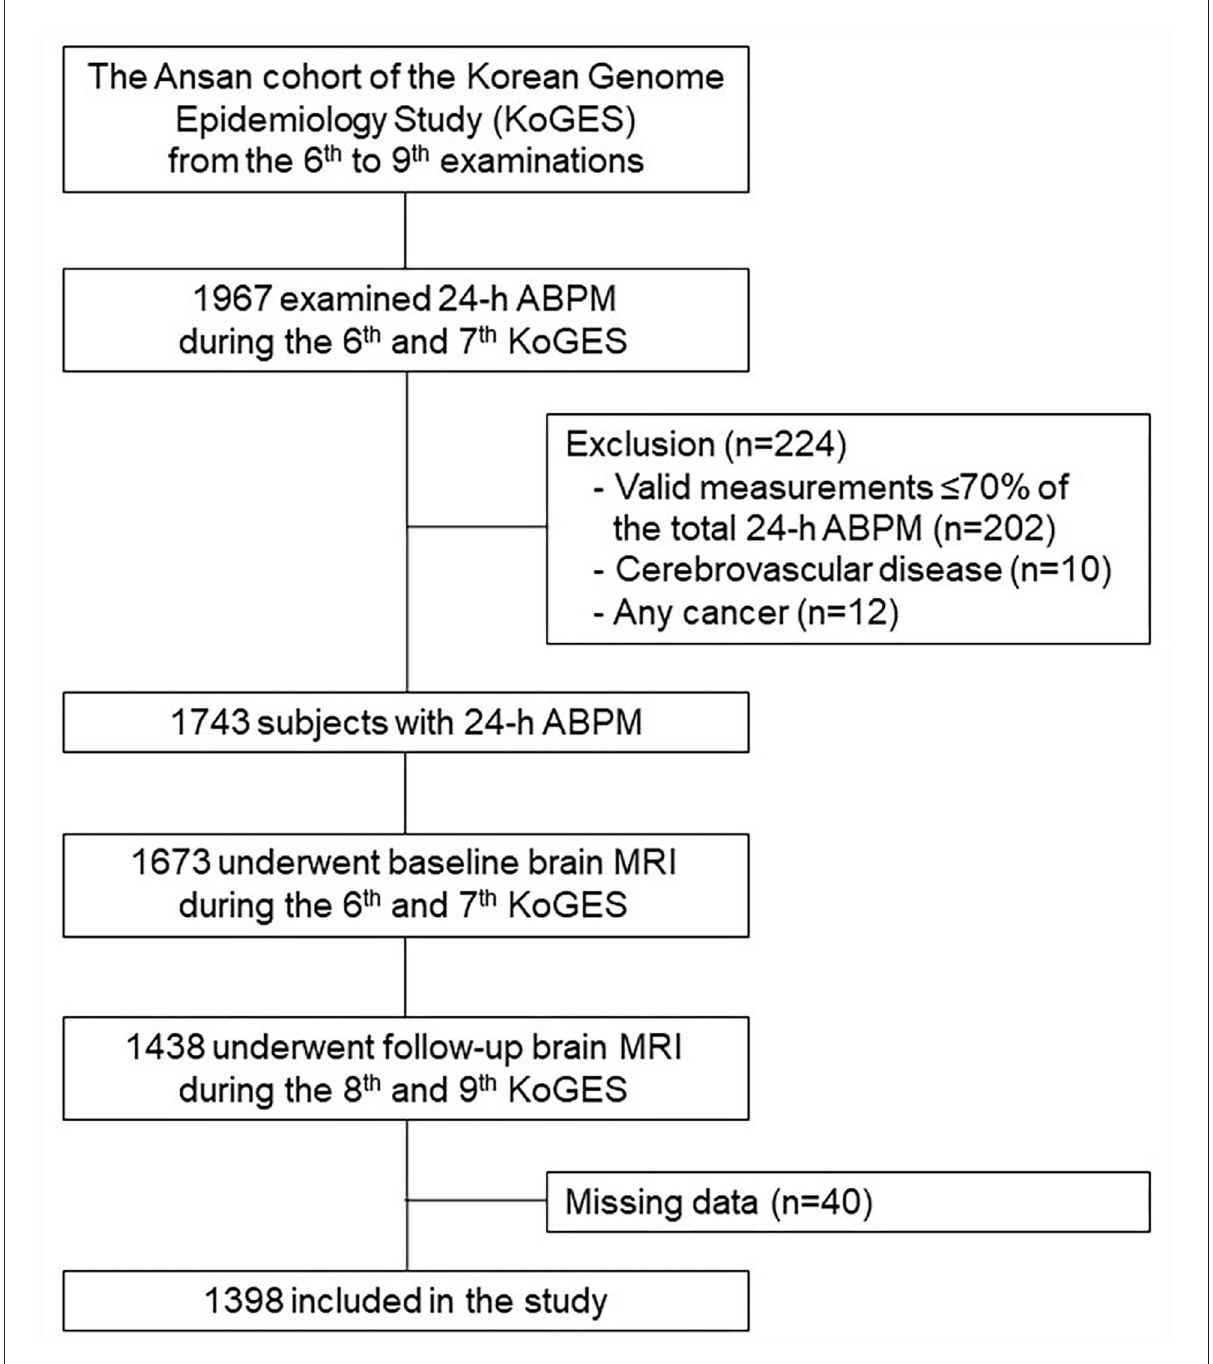
FIGURE1 A flowchart of the selection process. ABPM, ambulatory blood pressure measurement; MRI, magnetic resonance imaging.